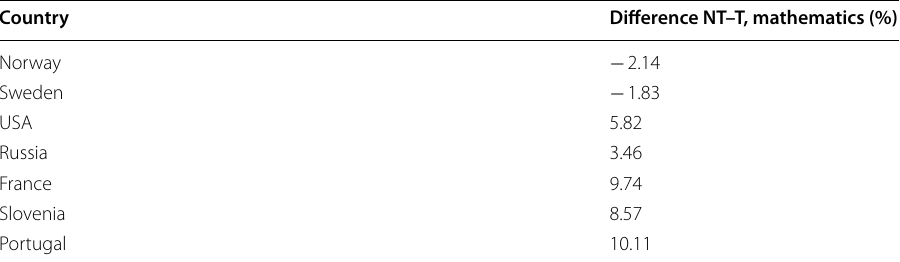
Table 10 Differences between average p -values for NT items and T items in